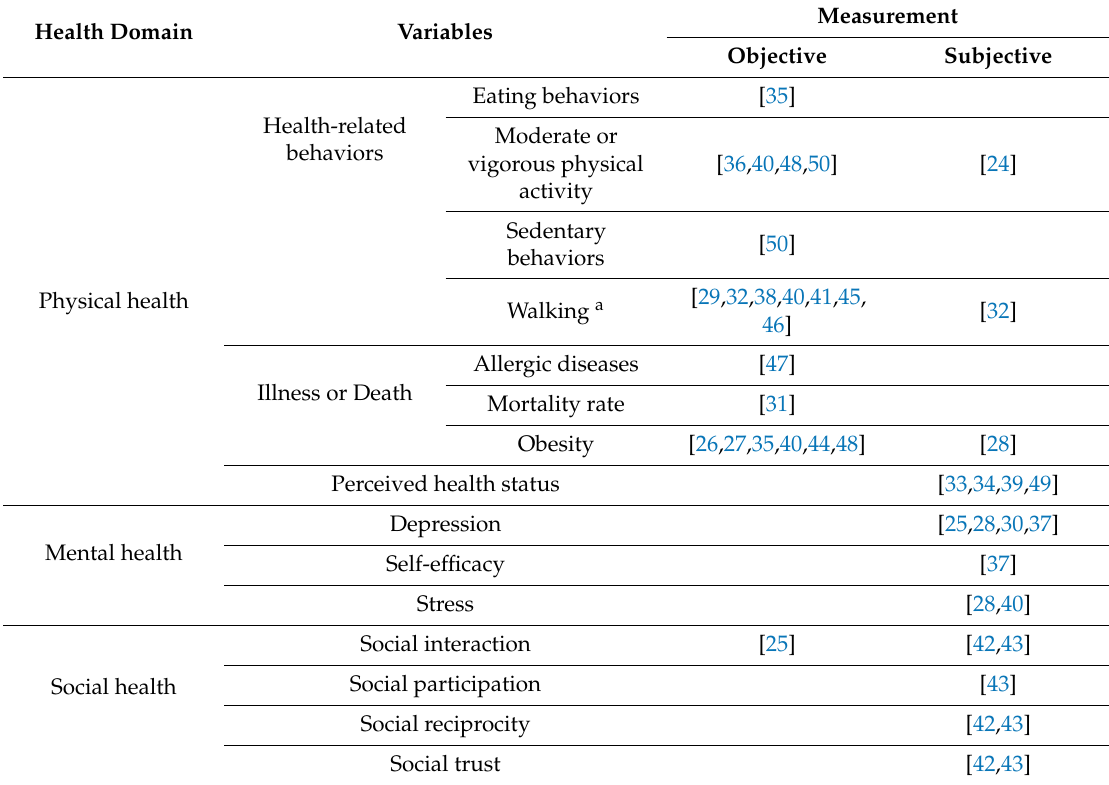
Table 3. Health-related variables from the reviewed